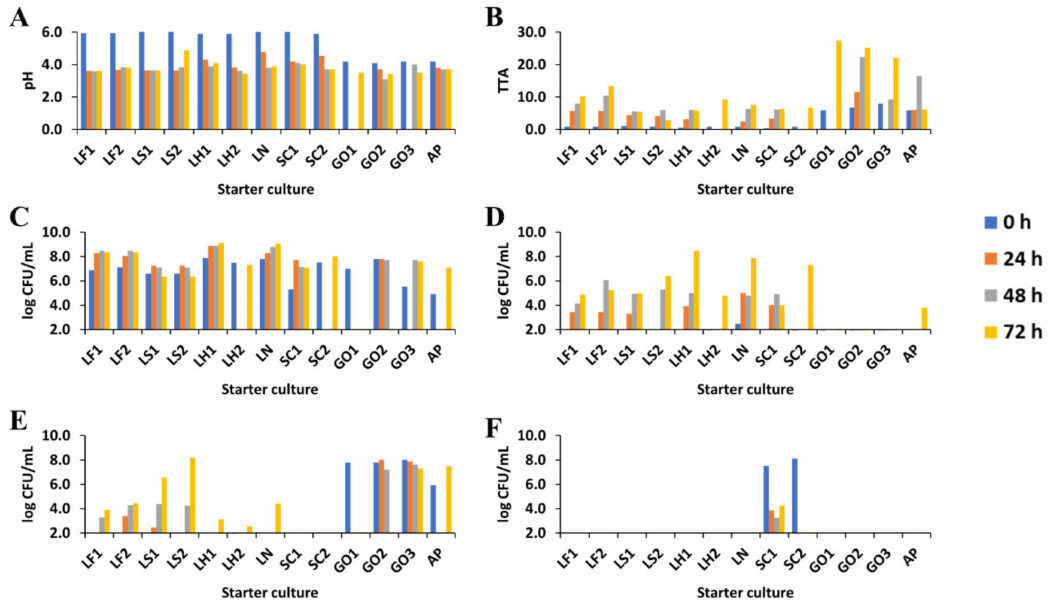
Figure 1. Evolution of pH ( A ), total titratable acidity (TTA) ( B ), and viable counts ( C – F ) of presumptive lactic acid bacteria ( C ), yeasts ( D ), acetic acid bacteria ( E ), and coagulase-negative staphylococci ( F ) during starter culture-initiated sourdough productions. The indication of the starter culture strains is as in Table